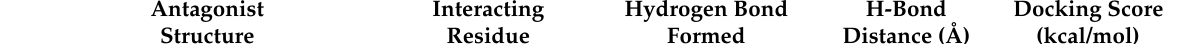
Table 5. Binding analysis of newly designed small ‐ molecule TLR7 antagonists. Comp.